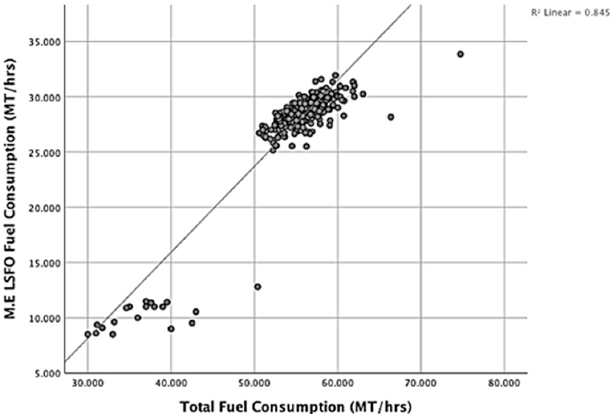
Electronics 2020 , 9 , x FOR PEER REVIEW Figure 2. Scatterplot between fuel consumption and M&E LSFO fuel consumption. Figure 2. Scatterplot between fuel consumption and M&E LSFO fuel consumption.